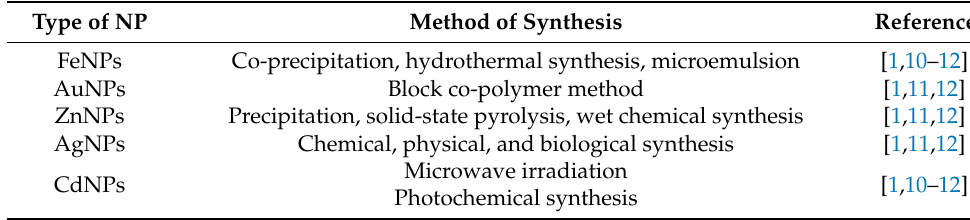
Table 1. Methods for the synthesis of metallic/metalloid